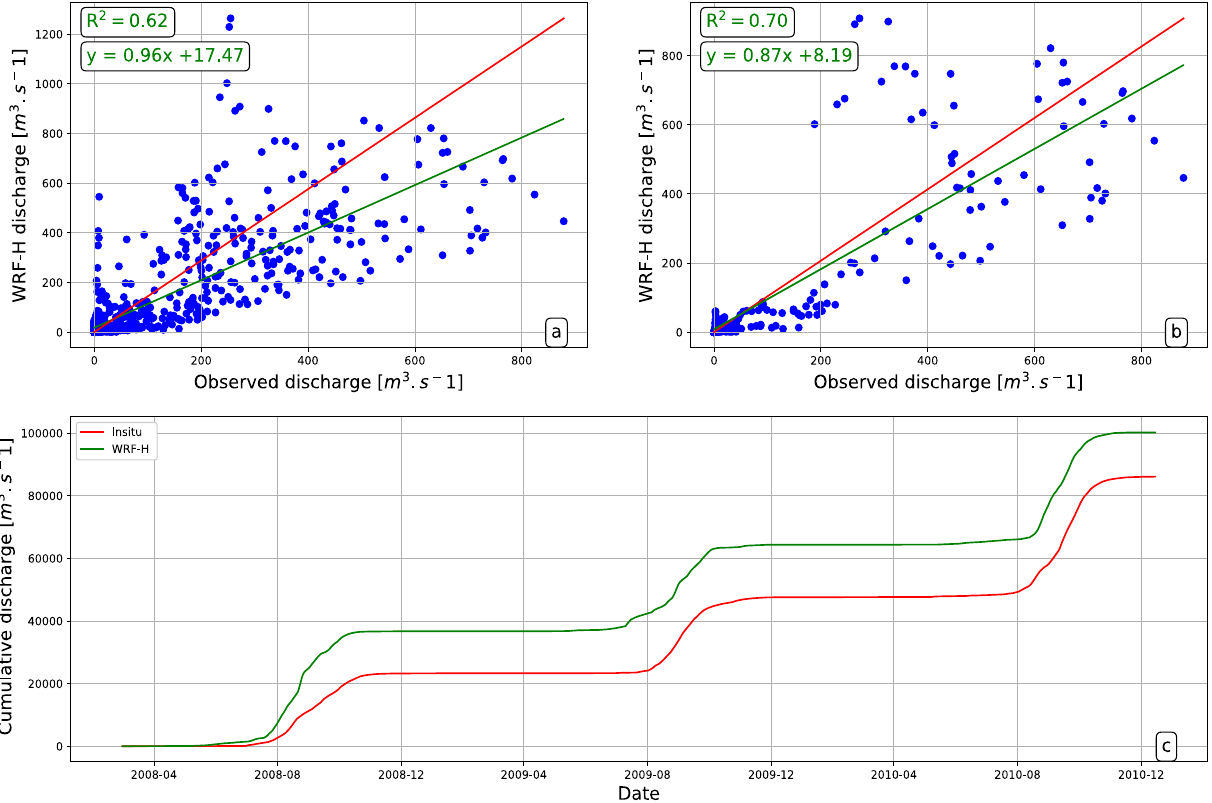
Figure 10. Scatter plot showing comparison of simulated and observed discharges ( a ) for the period 2008–2010, and ( b ) for the flooding year 2010, and ( c ) the cumulative of simulated and observed discharge at Bétérou.